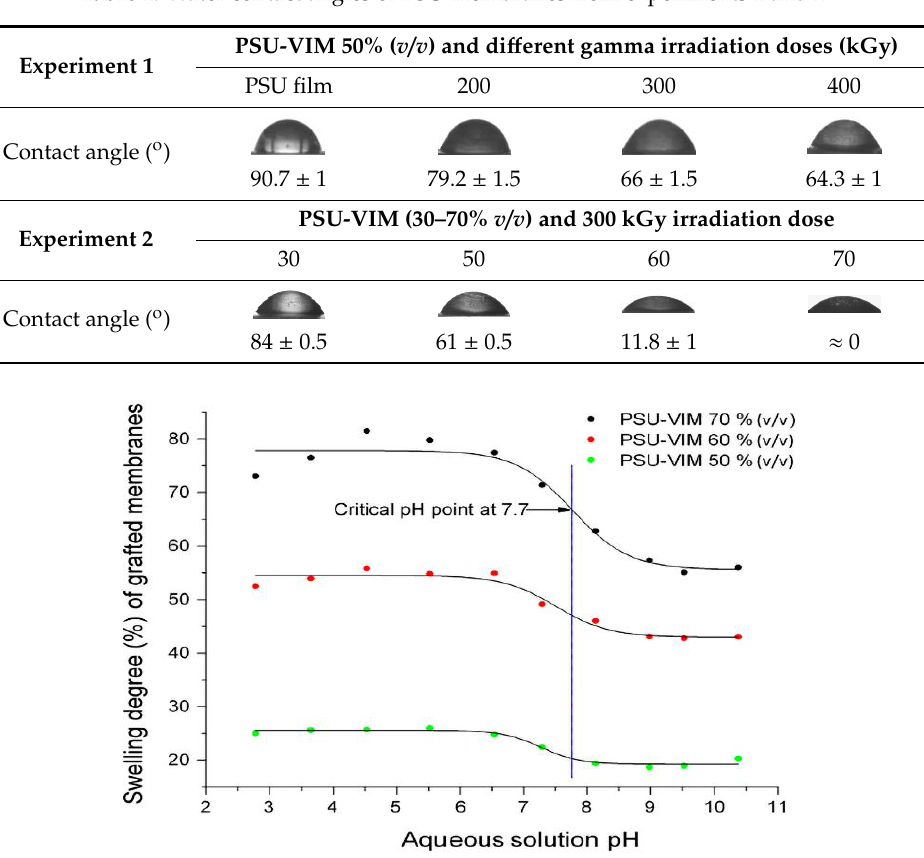
Figure 5. Swelling degree percentage (%) as a function of pH values for the grafted PSU membranes, with an irradiation dose of 300 kGy and VIM monomer concentrations of 50%–70% (v/v), from Experiment 2.